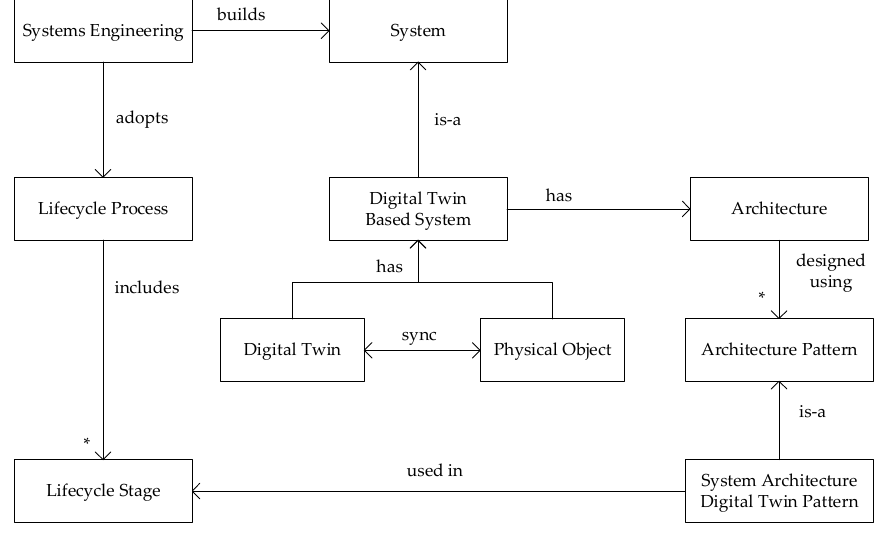
Figure 2. Metamodel for system architecture digital twin patterns.